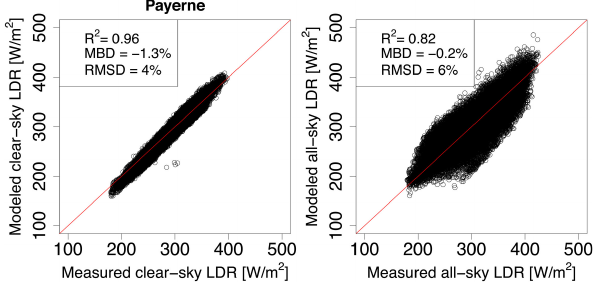
Fig. 9. Scatter plots of measured and modeled clear- and all-sky LDR according to Konzelmann et al. (1994) and Eq.